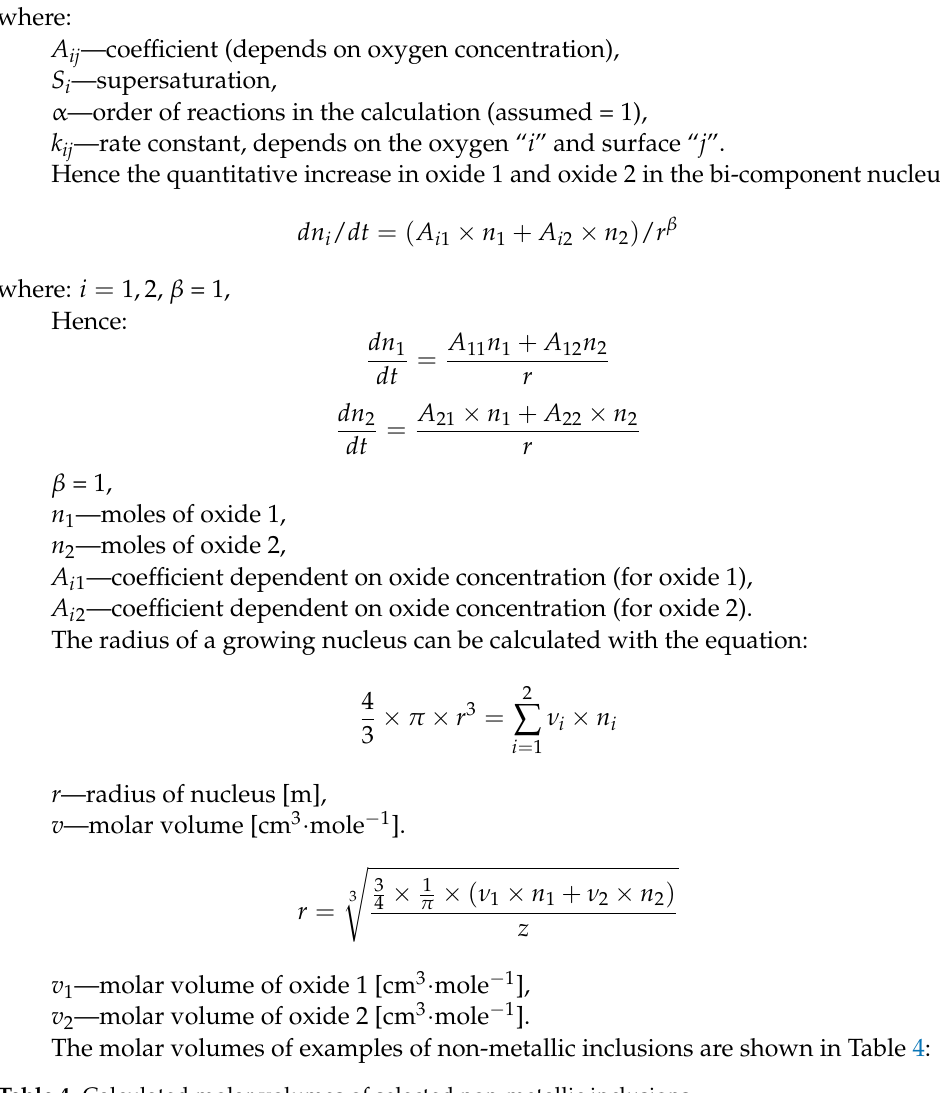
Table 4. Calculated molar volumes of selected non-metallic